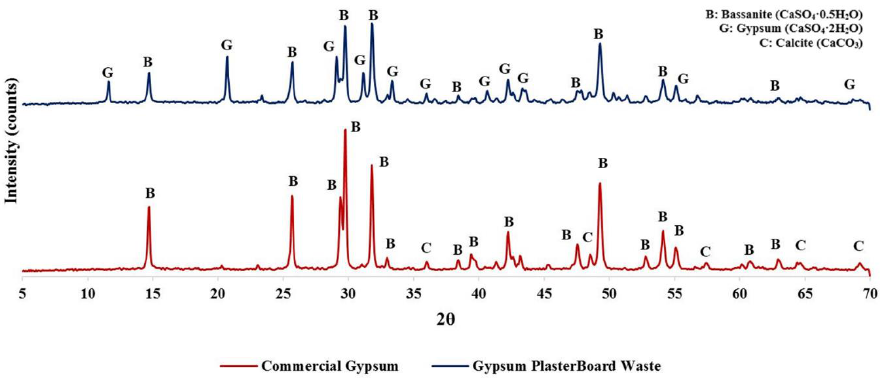
Figure 2. X-ray diffraction ( XRD) of both types of gypsum waste used. Figure 2. X-ray di ff raction (XRD) of both types of gypsum waste used. Table 1. Composition of all the gypsum mixes under study.